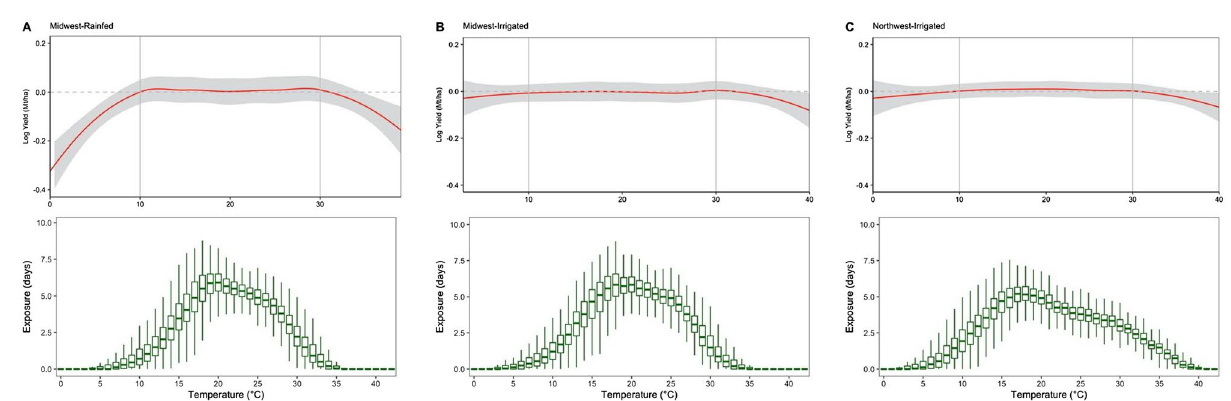
Figure 2. Nonlinear relation between temperature and yield for the ( A ) Midwest-Rainfed, ( B ) Midwest- Irrigated, and ( C ) Northwest-Irrigated. Graphs at the top of each frame display changes in log yield if the crop is exposed for one day (24 h) to a particular 1 °C temperature interval. Exposure (days) was calculated as the sum of the fraction of a day during which temperatures fall within each interval. The 95% confidence intervals are shown by gray shaded area. Histograms at the bottom of each frame display the average temperature exposure for all yield observations in each production